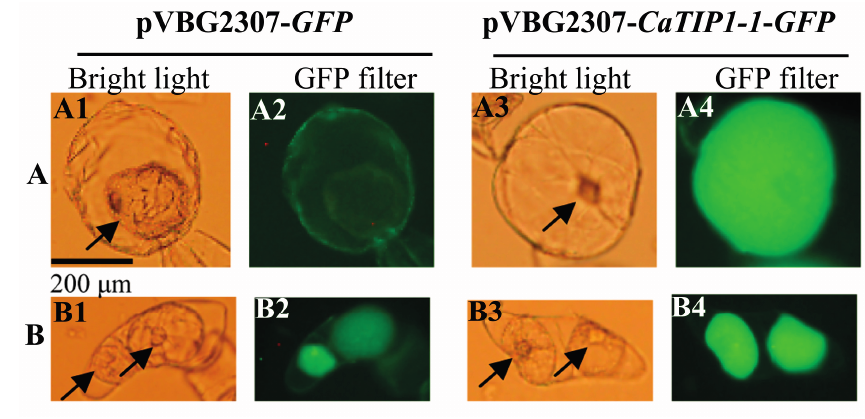
Figure 1. Subcellular localization of CaTIP1-1. A fluorescent image was taken with a fluorescent microscope (BX51; Olympus) and a 50-W mercury lamp. ( A ) Control (untreated) suspension-cultured cells of tobacco and ( B ) suspension-cultured cells of tobacco were plasmolysed in 0.8 M mannitol for 15 min. The arrow indicates the nucleus; ( A1 , A3 , B1 , B3 ) image taken by a fluorescent microscope (bright light); ( A2 , A4 , B2 , B4 ) image taken by a fluorescent microscope (GFP